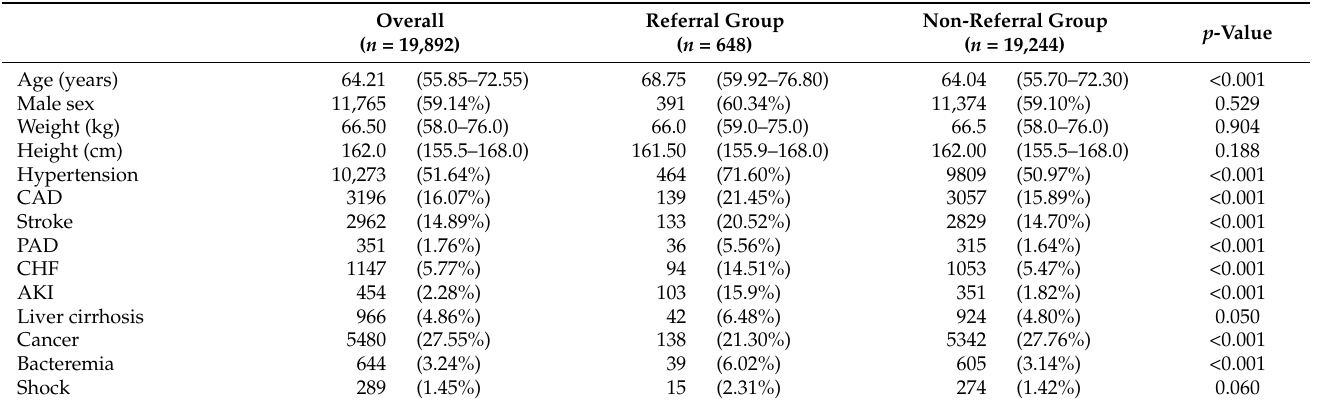
Table 1. Baseline demographic and clinical characteristics of the included patients in experiment